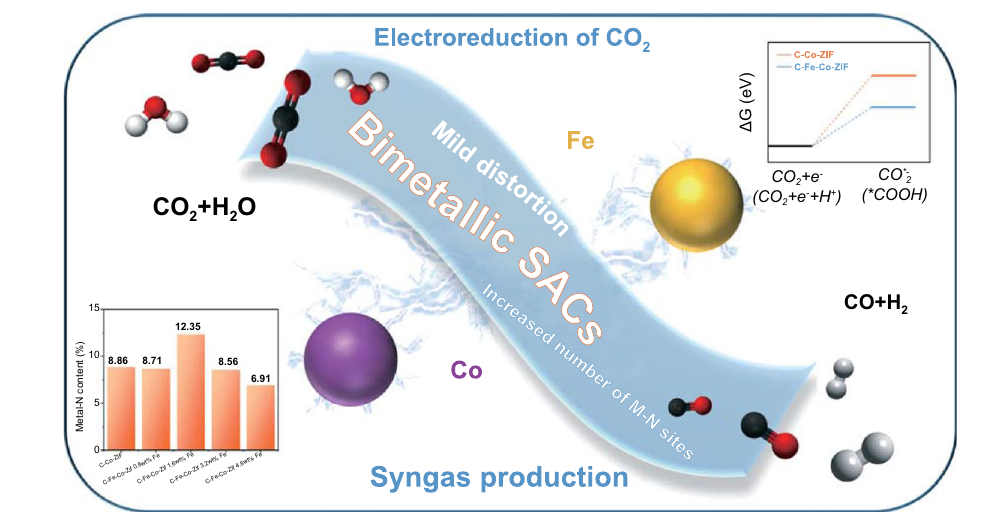
Fig. 8 Schematic reaction mechanism of bimetallic catalysts for ECO 2 RR